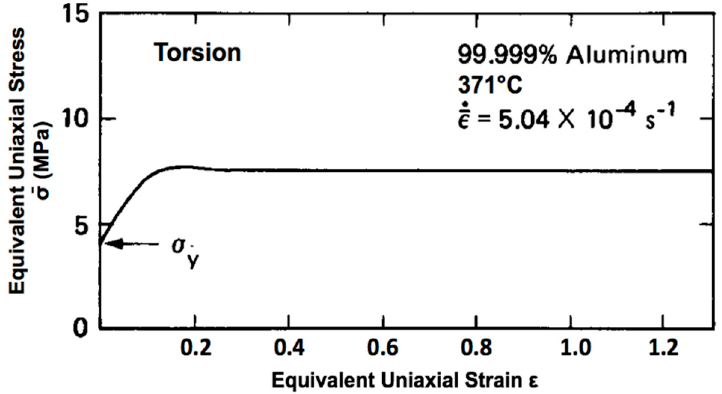
Figure 1. The stress versus strain behavior of 99.999% pure polycrystalline aluminum at 371 °C in torsion.